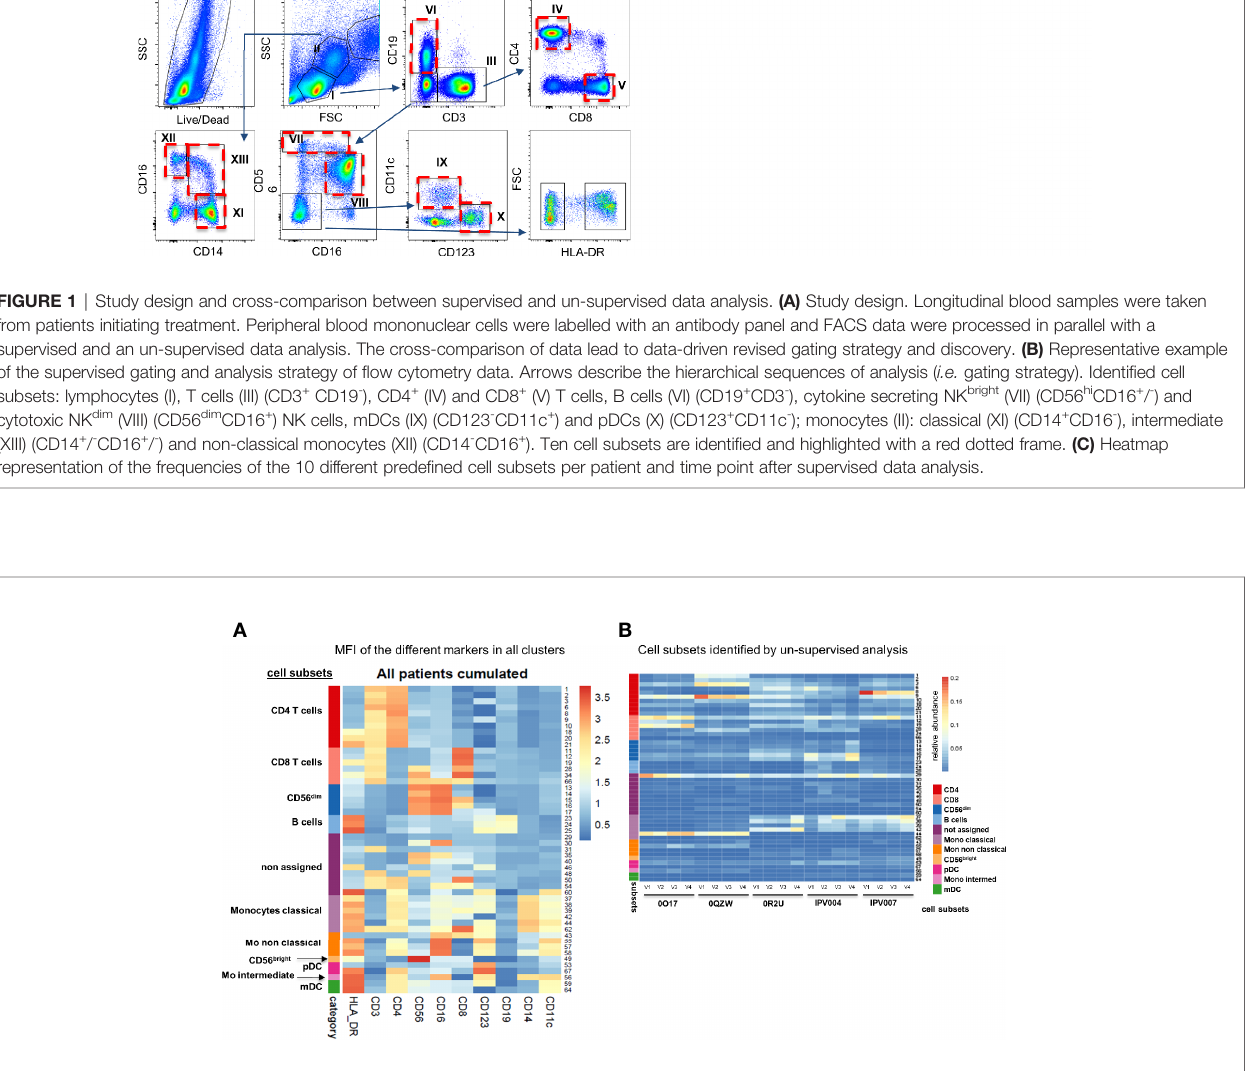
FIGURE 2 | Expression of different markers in all clusters. (A) Heatmap of the mean fl uorescence intensity (MFI) for each marker in all identi fi ed clusters. Cumulative data of all patients and time points (n=20). (B) Heatmap representation of 50 good quality clusters identi fi ed per patient and time point with the unsupervised analysis using MegaClust. From the 50 clusters, 40 could be attributed to the 10 prede fi ned cell subsets from the supervised analysis while 10 clusters could not be assigned.